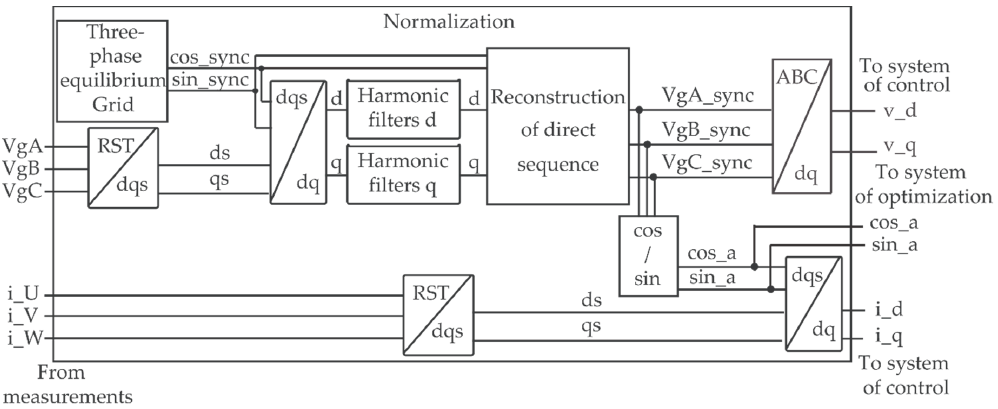
Figure 6. Scheme of the “Normalization” subsystem.